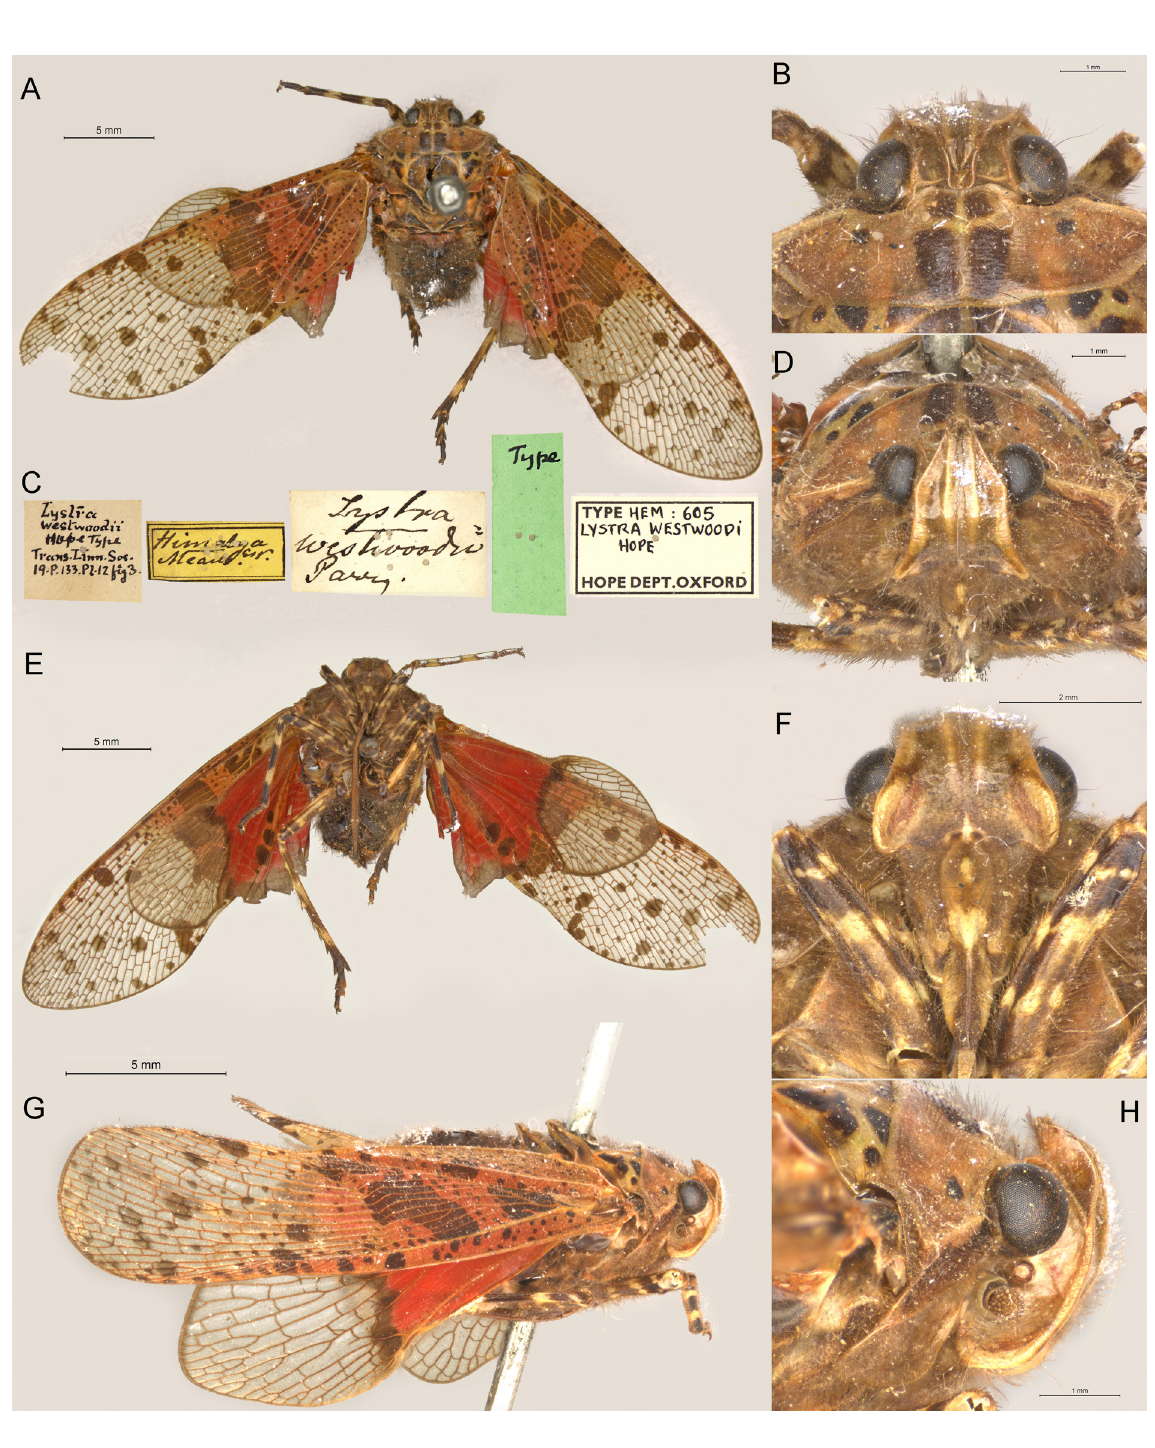
Fig. 9. Limois westwoodii (Hope, 1843) holotype, adult female. A . Dorsal view. B . Head and thorax, dorsal view. C . Labels. D , F . Face. E . Ventral view. G . Right lateral view. H . Head and thorax, right lateral view (showing reflexed protuberance of the vertex). Photographs by K.